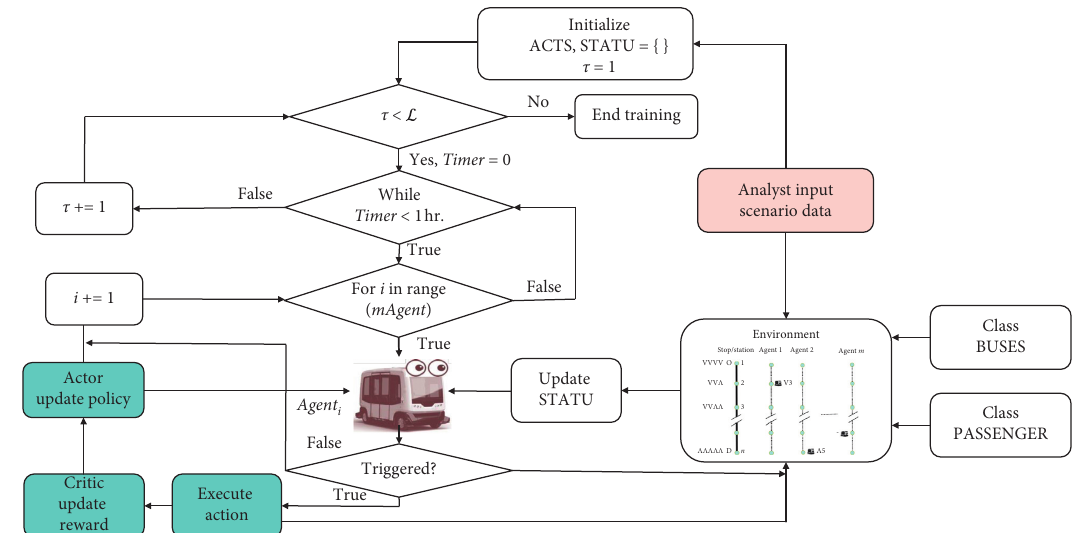
Figure 3: Flowchart of the simulation